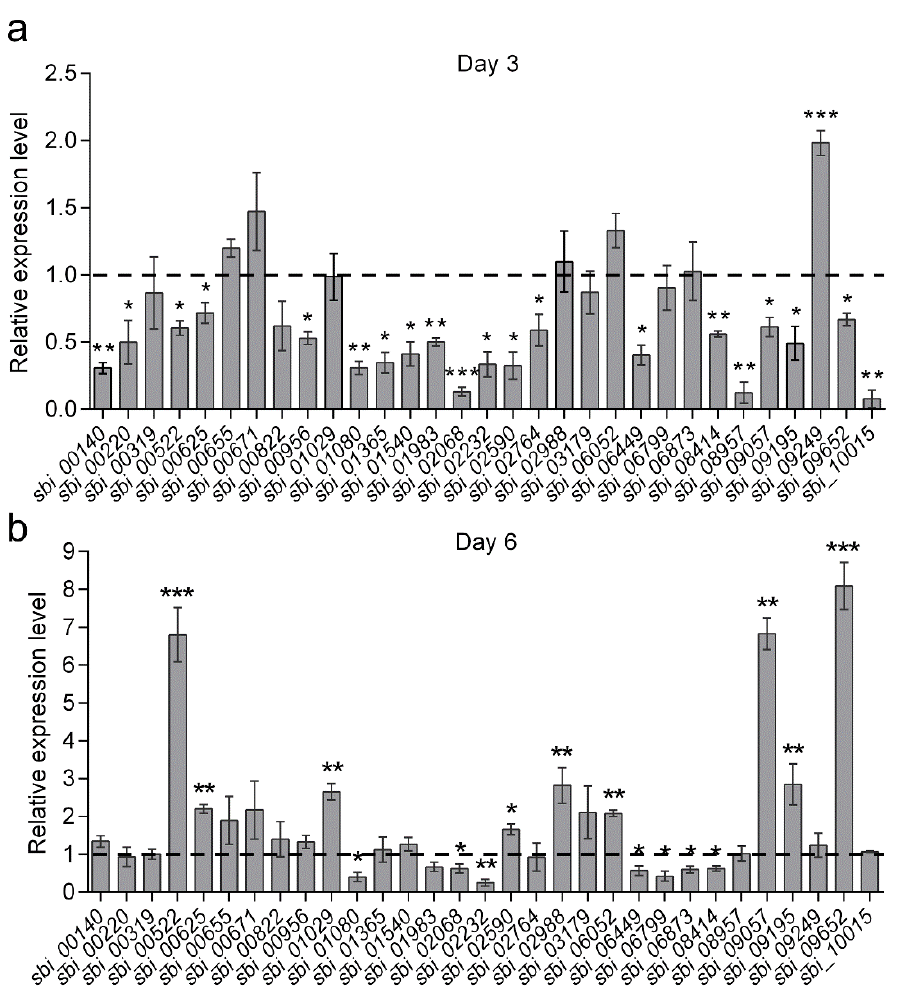
Figure 4. The qRT-PCR analysis of 31 PKS, NRPS and PKS-NRPS biosynthetic core genes in BC04 and BC04/OsspH ( a ) on day 3 and ( b ) on day 6. RNA samples were isolated from 3- and 6-day cultures. The expression level of each biosynthetic core gene in BC04 was assigned a value of 1 (represented by the dotted line). 16S rRNA was used as the internal control. Data are presented as the averages of three triplicates. Error bars show standard deviations. * p < 0.05, ** p < 0.01, *** p < 0.001.